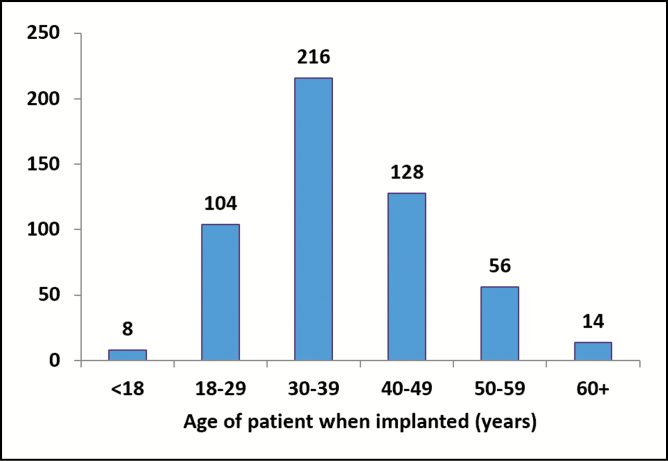
Age distribution at enrollment for all cohorts (reprinted from Duteille et al12).